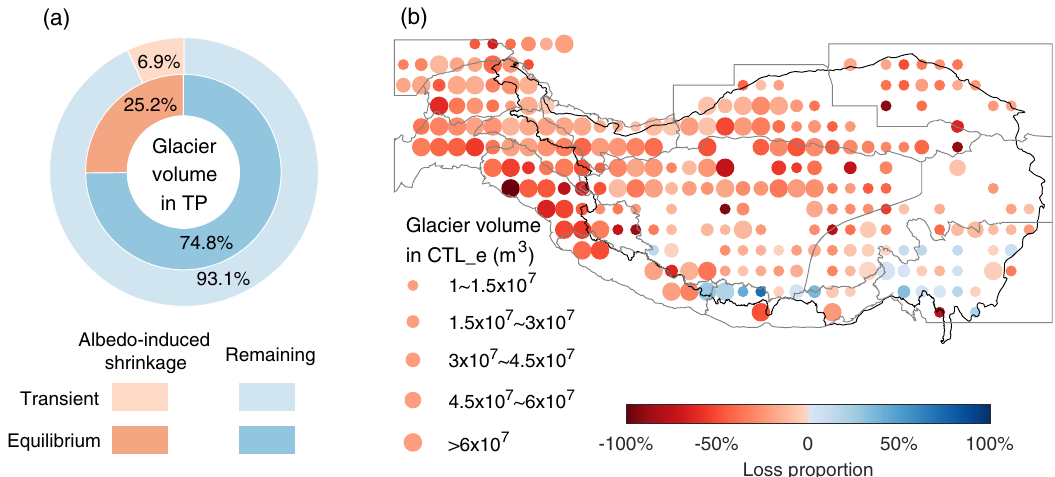
Fig. 4 | Thealbedo-inducedshrinkage ofglacier volumein the Tibetan Plateau (TP)anditssurroundingranges.a Theproportionofalbedo-inducedshrinkageof glacier volume and the remaining one on the centennialscale(outerring, fromthe transientsimulations)andattheequilibriumstate(innerring,fromtheequilibrium simulations). b Thespatialpatternofequilibrium-stateglaciervolumeinCTL_eand its loss proportion of SCE_e relative to CTL_e. The loss proportion is computed as the difference between the fi nal 1000-year glacier volume of SCE_e and CTL_e dividedbythatofCTL_e.TheblacklineindicatestheboundaryofTP.Thegraylines